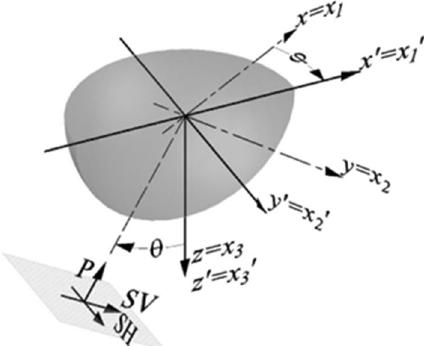
Fig. 1 Systems of reference. The 3D reference system is the Cartesian one x , y and z for the horizontal axis and the downward vertical one, respectively. The half‑space corresponds to z 0. It is common use ≥ in the text and elsewhere that x x 1 , y x 2 and z x 3 . This sketch = = = shows the incidence of a generic homogeneous plane wave with incidence angle θ with respect to the vertical and forward azimuth φ measured from the x ‑axis. The angle θ is measured from z ‑axis within the plane ( x’ , z’ ). Only to illustrate the polarization, the thick arrows show positive particle motion of the incoming P , SV and SH waves. Particle motion polarization vectors for incident and reflected waves are given in the